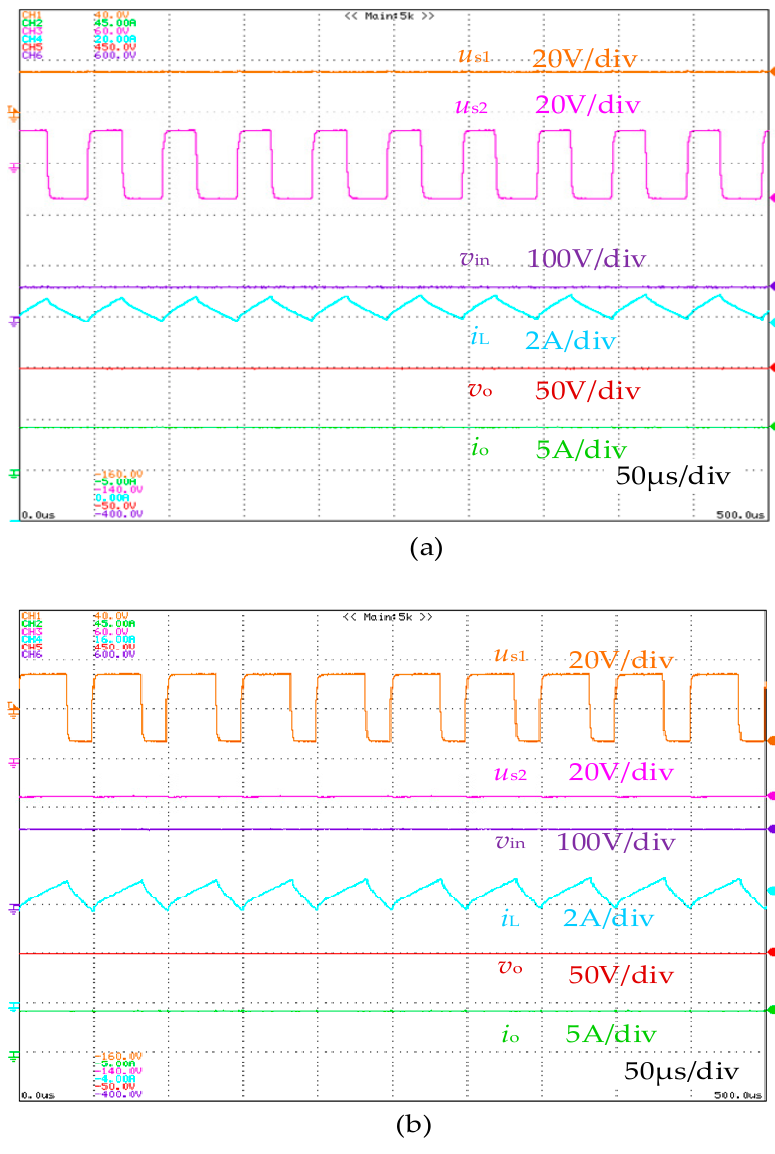
Figure 8. Experiment results in steady state: ( a ) v in < v o (boost mode) and ( b ) v in > v o (buck mode) .